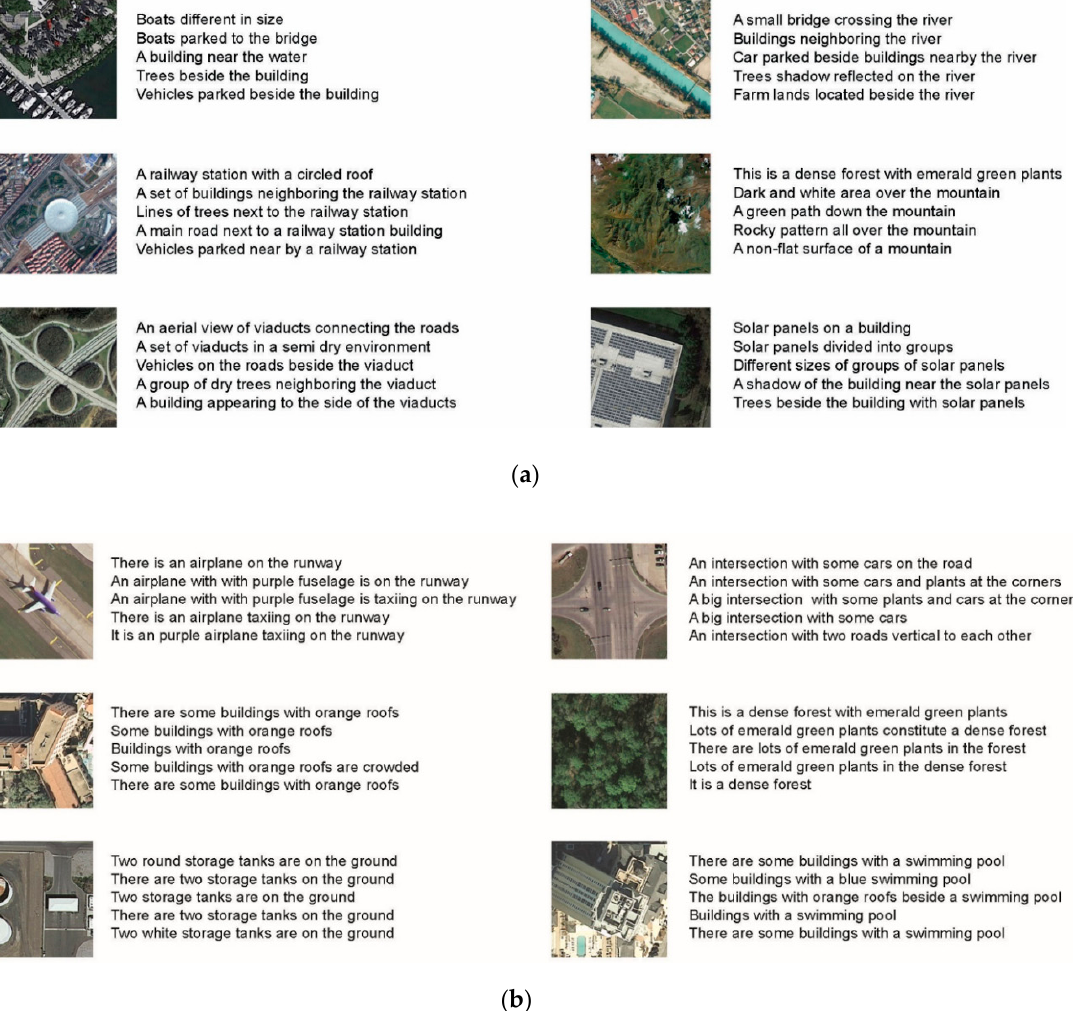
Figure 3. Example of images with their corresponding captions ( a ) TextRS, ( b ) Merced.